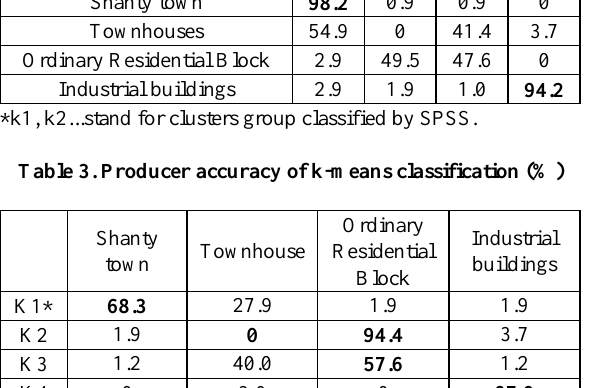
Table 4. User accuracy of k-means classification (%)